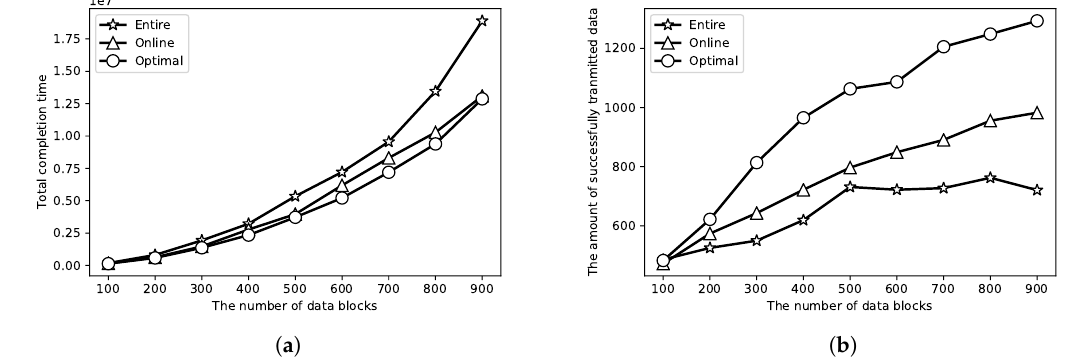
Figure 9. Result with simulated energy receiving process. ( a ) simulation for total completion time; ( b ) simulation for maximum successfully transmitted data